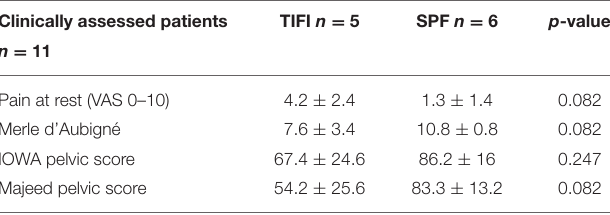
TABLE 3 | Pain and clinical scores (Merle, Iowa, Majeed) after TIFI or SPF. Clinically assessed